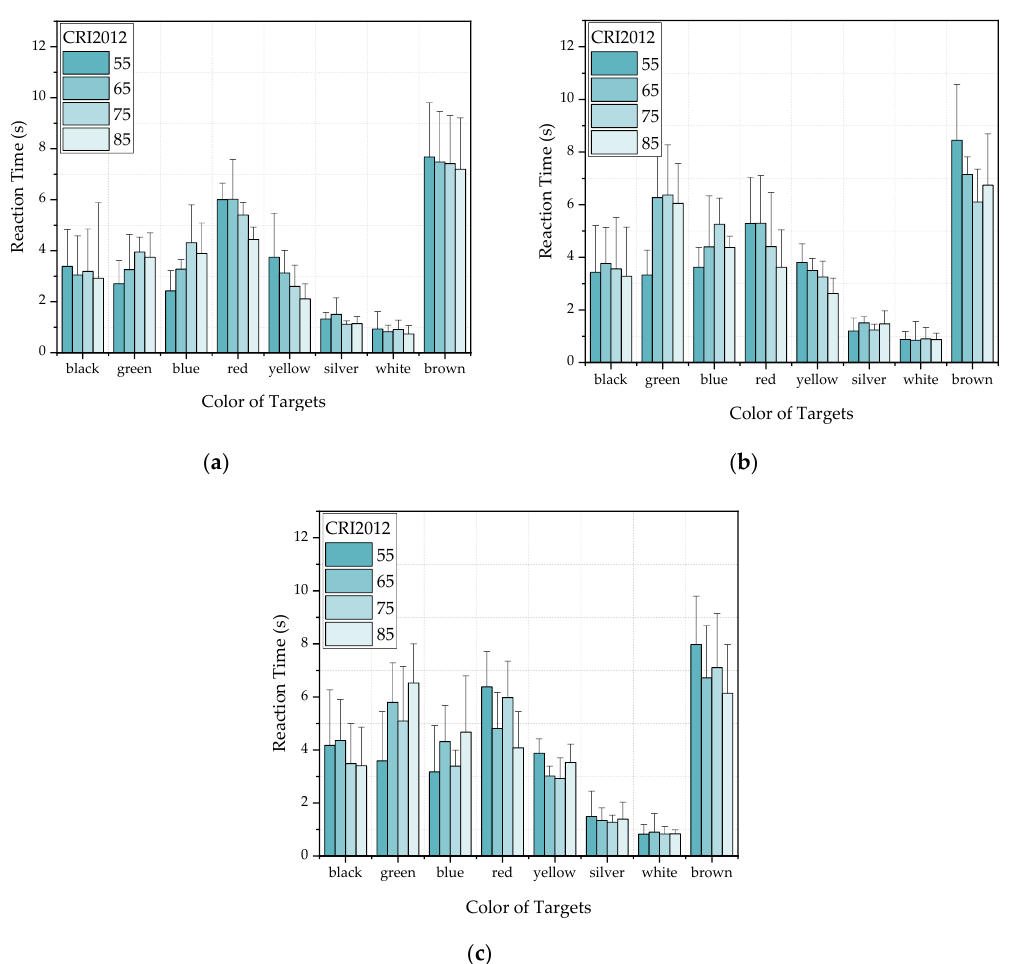
Figure 12. The mean reaction time of all subjects under different CRI2012s and LP-CCTs when HP-CCT is 3000 K. ( a ) LP-CCT = 2800 K. ( b ) LP-CCT = 4500 K. ( c ) LP-CCT = 6400 K. Error bar shows the standard deviation.